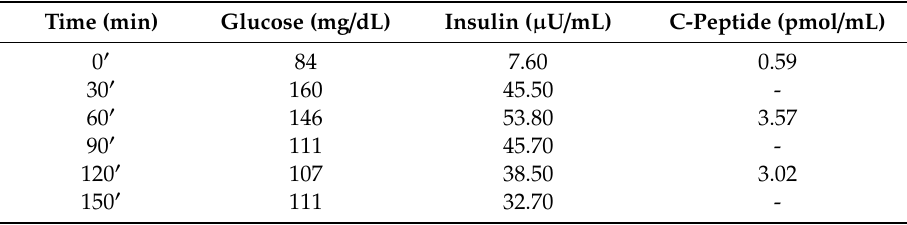
Table 2. Results of the oral glucose tolerance test (75 g glucose